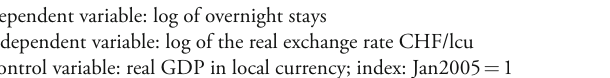
Table 10: Overall Findings with More than One